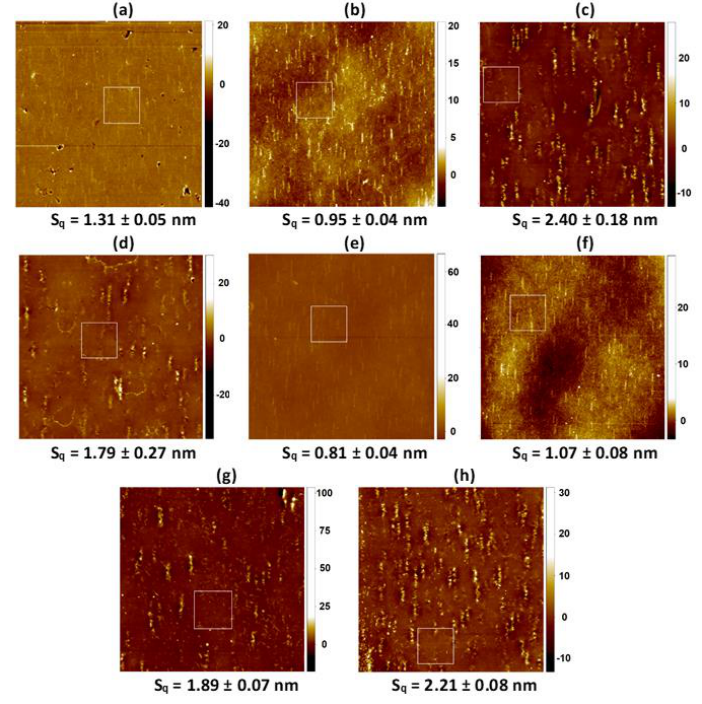
Figure 4. AFM micrographs for the 20 × 20 µ m 2 scanned areas: PET air /AA ( a ), PET air /AA/DOPC ( b ), PET air /AA/CsA ( c ), PET air /AA/DOPC-CsA 0.50 ( d ), PET air /AA/DOPC-CsA-LG 0.25 ( e ), PET air /AA/DOPC-CsA-LG 0.50 ( f ), PET air /AA/DOPC-CsA-LG 0.75 ( g ), PET air /AA/LG ( h ). Z scale: nm.